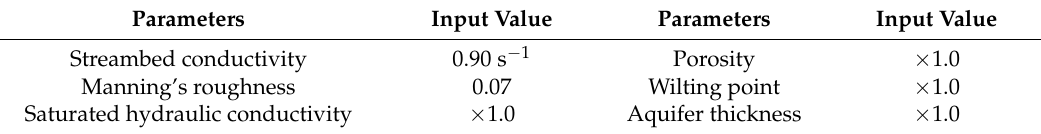
Table 2. Calibration results of land surface-hydrological model (LSM-HMS).